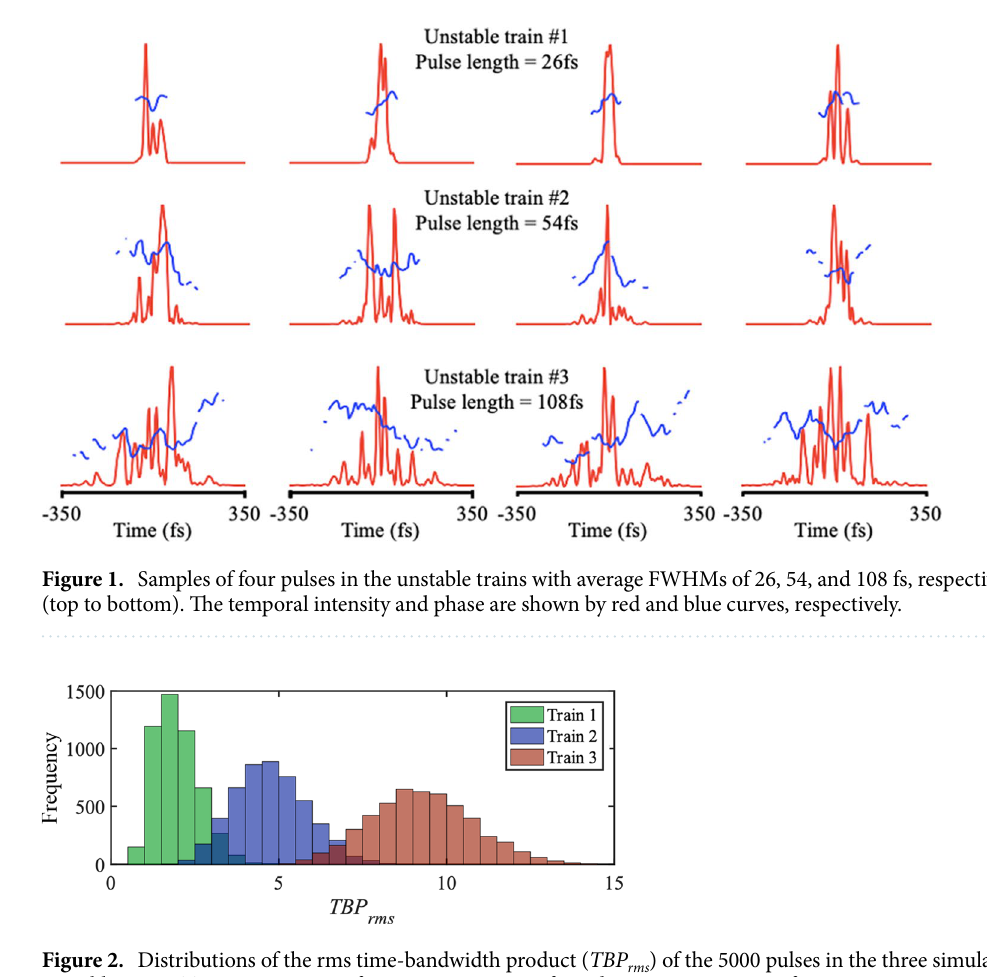
Figure 2. Distributions of the rms time-bandwidth product ( TBP rms ) of the 5000 pulses in the three simulated unstable trains: Train 1: τ FWHM = 26 fs; train 2: τ FWHM = 54 fs, and train 3: τ FWHM = 108